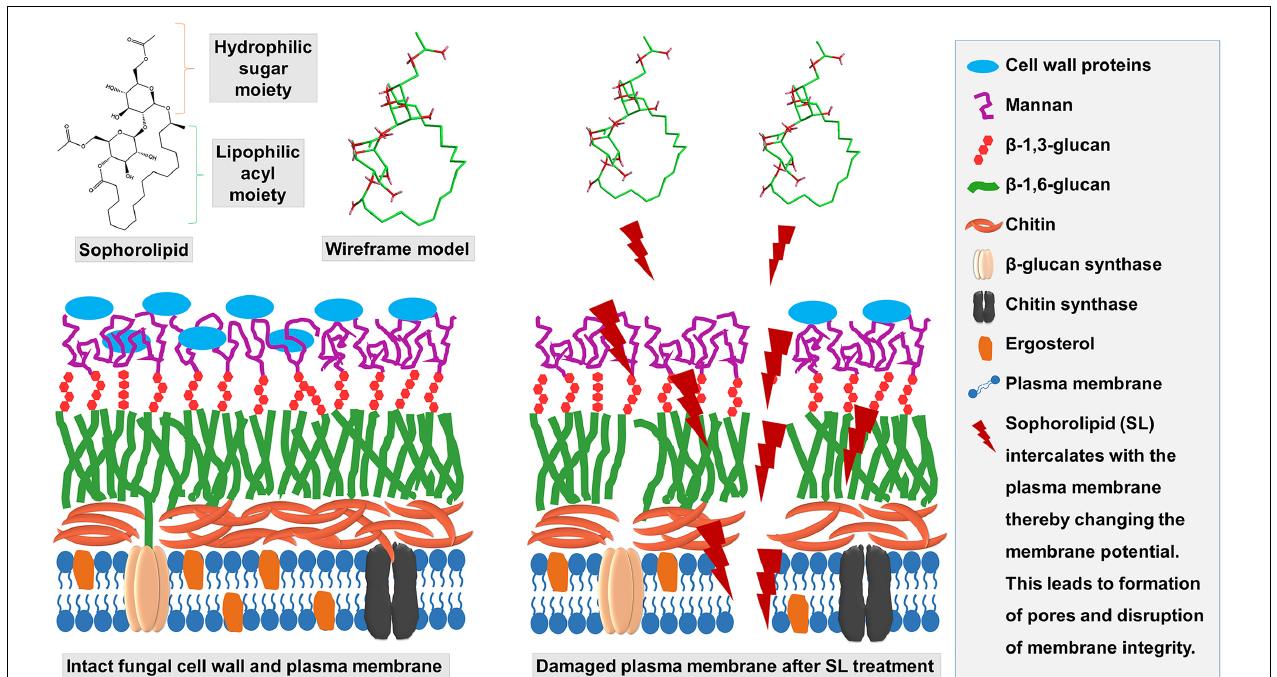
FIGURE 10 | Schematic depicting the mechanism of action of SL-YS3 on mycelial membrane of T. mentagrophytes . Owing to the amphiphilic nature, SL-YS3 might alter the permeability of the cell membrane of T. mentagrophytes , interfering with the ion transport leading to cell membrane rupture and cell death.